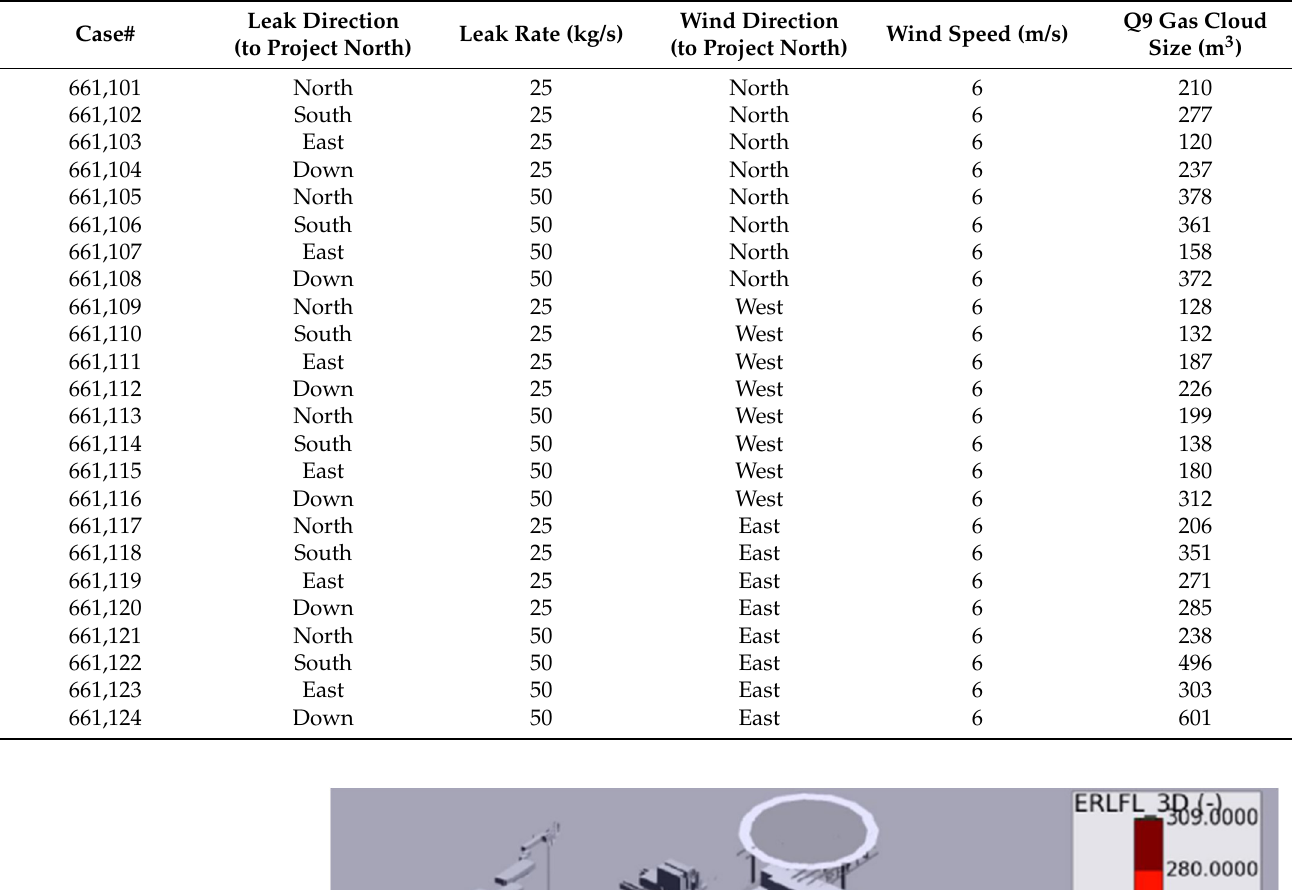
Table 3. Dispersion cases set up and Q9 explosive gas cloud result for Leak1.